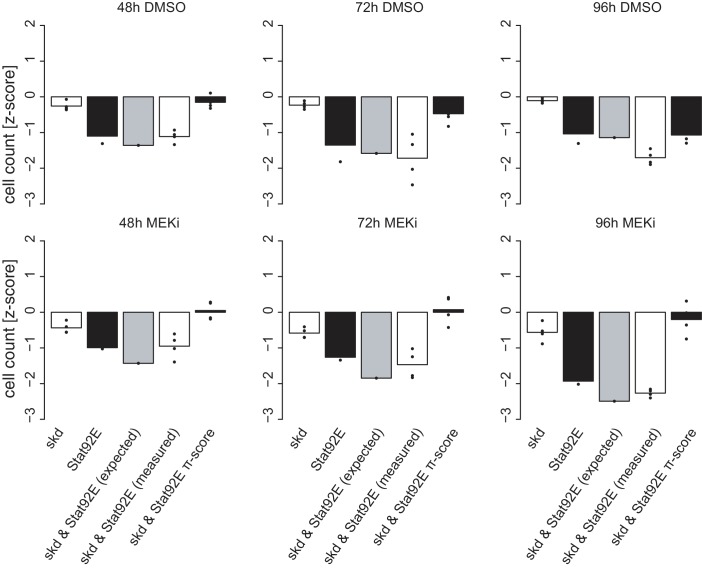
Time- and treatment-dependent interaction between skd and Stat92E.Interactions measured by π-scores were analyzed across all conditions. Shown bars are always from left to right: skd knock down, Stat92E knockdown, expected co-perturbation phenotype, measured co-knockdown of skd and Stat92E and the calculated difference between observed and detected co-perturbation (π). All bars are in units of cell count z-score normalized. Single knockdown phenotypes rarely change over time, while the π-score does change the interaction is largely treatment sensitive. Bars are mean of four replicates.